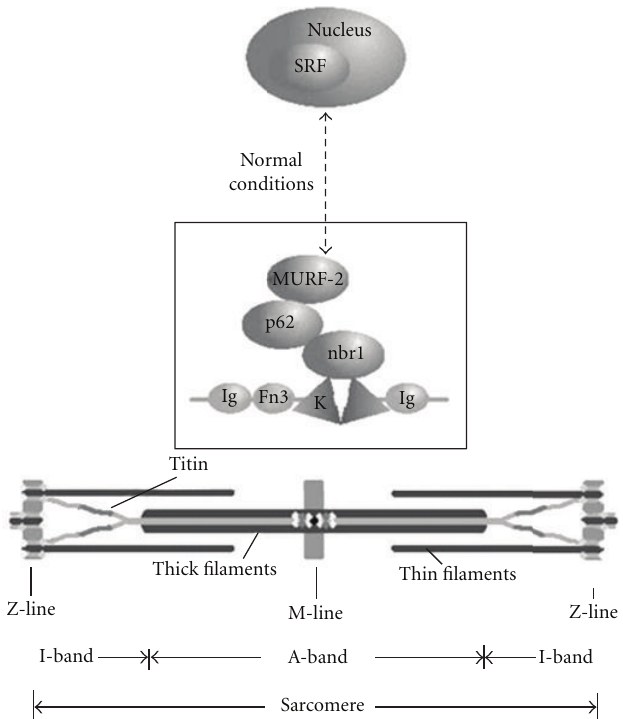
Figure 3: MuRF-2 localization on titin molecule